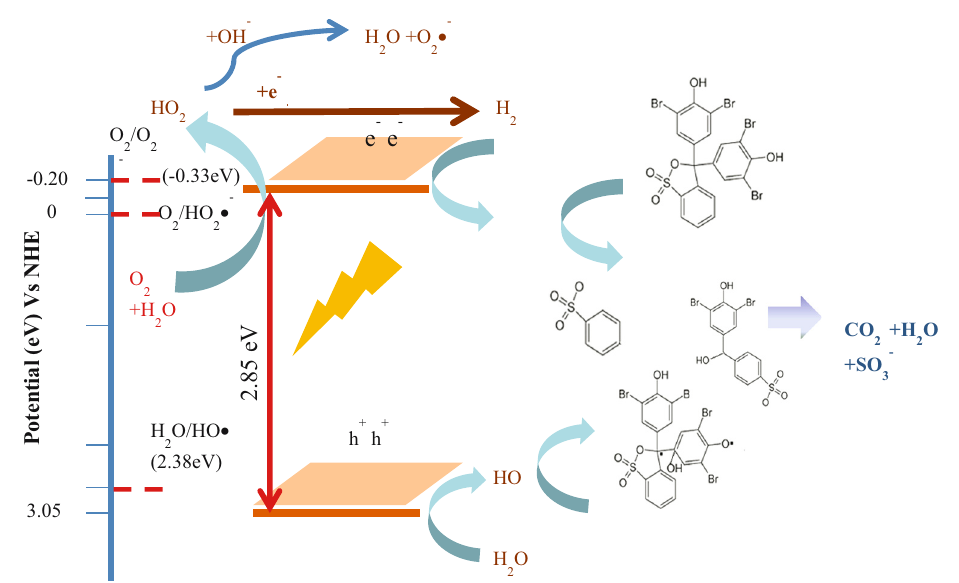
Figure 7: Mechanism of the photocatalytic degradation of organic molecules using iron oxide/clay